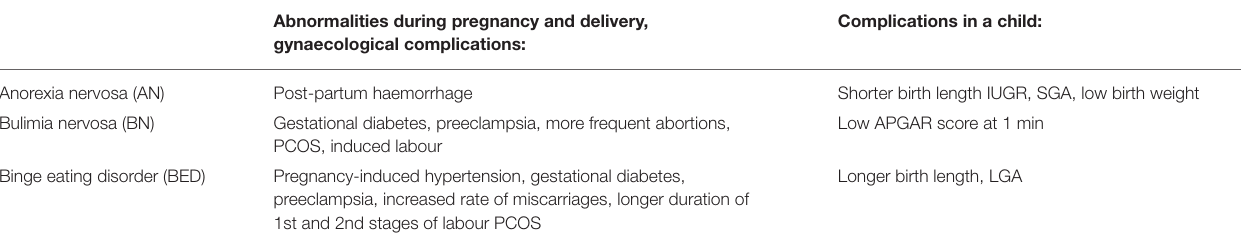
TABLE 2 | Possible complications in pregnant women with ED and their newborns (5, 6, 15, 17,